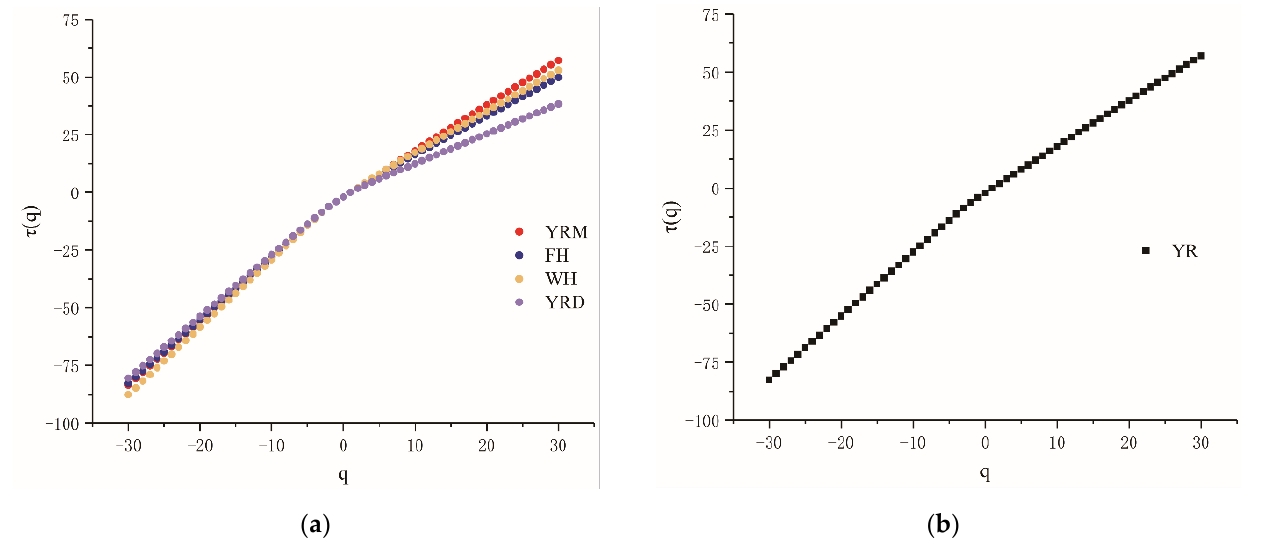
Figure 5. The relationships between the mass exponent τ ( q ) and the moment order q of ( a ) The Yellow River Mainstream Basin (YRM), the Fenhe River Basin (FH), the Weihe River Basin (WH), the Yellow River Downstream Basin (YRD); and ( b ) The Yellow River Basin (YR).